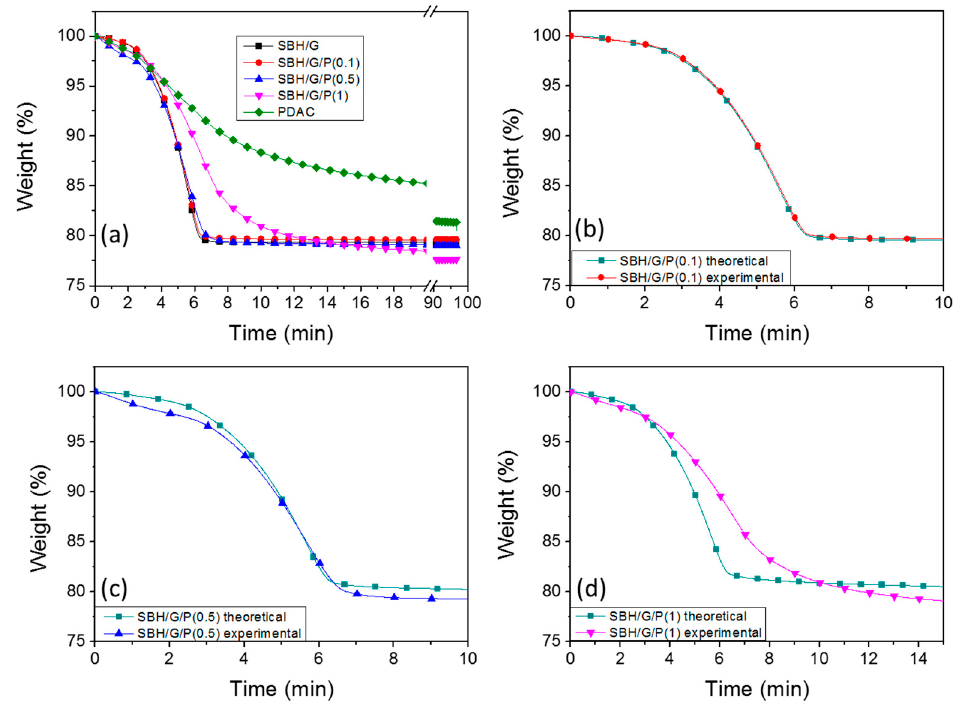
Figure 5. Thermogravimetric analysis (TGA) weight plots of the different SBH/G/PDAC mixtures, compared with pristine PDAC ( a ), and comparison between experimental end calculated data for SBH/G/P(0.1) ( b ), SBH/G/P(0.5) ( c ), and SBH/G/P(1) ( d ).